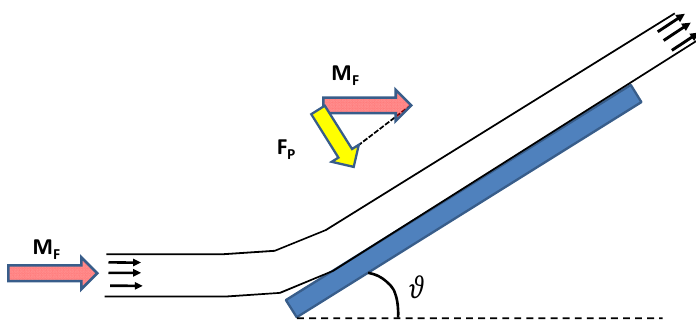
Figure 8. A fluid jet hitting an inclined